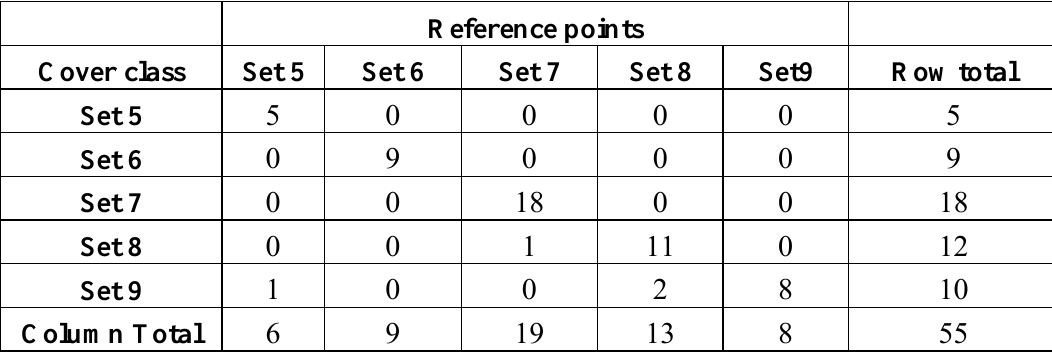
Table 2A. Another sample of classification result error matrix of the corrected (image 1, Milwaukee Urban areas).